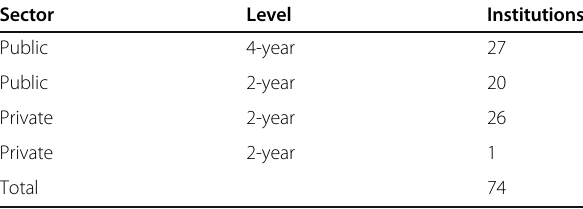
Table 1 Institution webpage types included in our sample